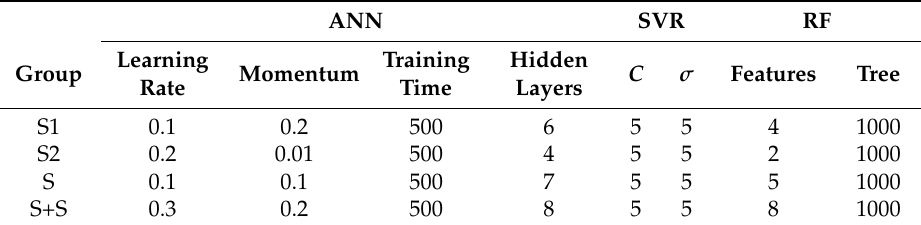
Table 6. Summary of AGB models by ANN, SVR and